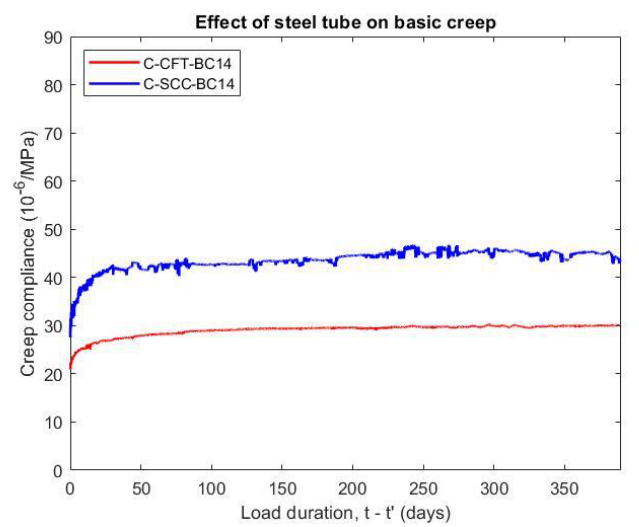
Figure 7. Basic creep compliance of CFT and SCC under applied stress at 14 days.